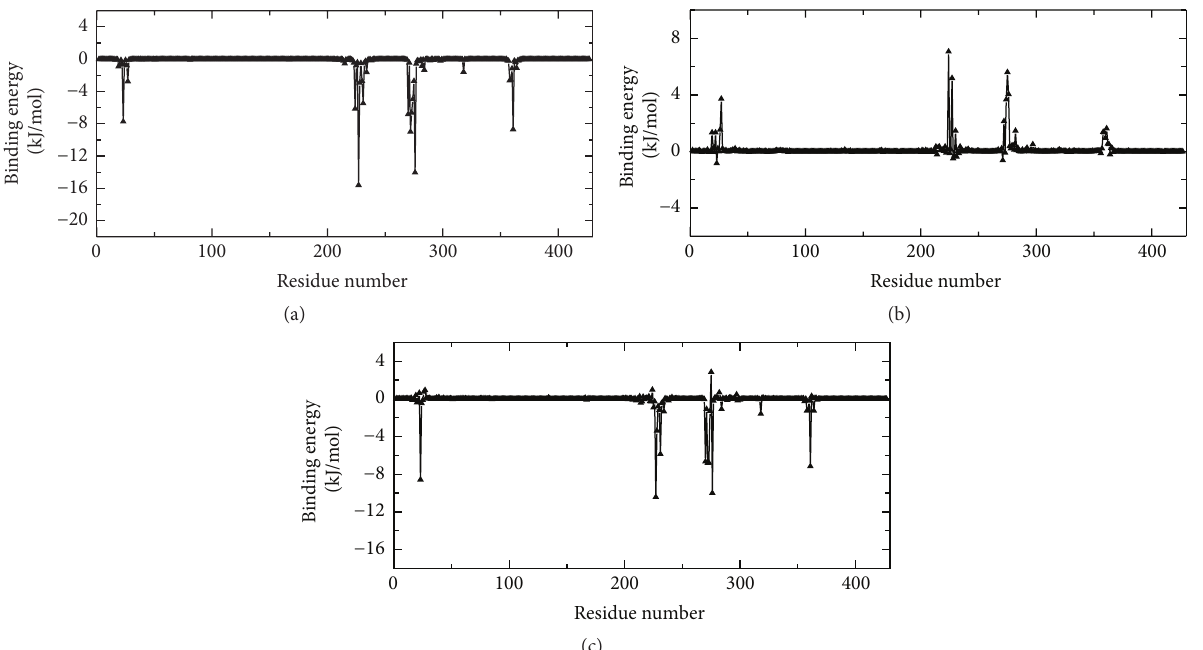
Figure 7: Energy contribution of each residue to the binding between L713283 and 𝛽 -tubulin. The energy distributions are divided into the nonpolar interaction (a), polar interaction (b), and total effect